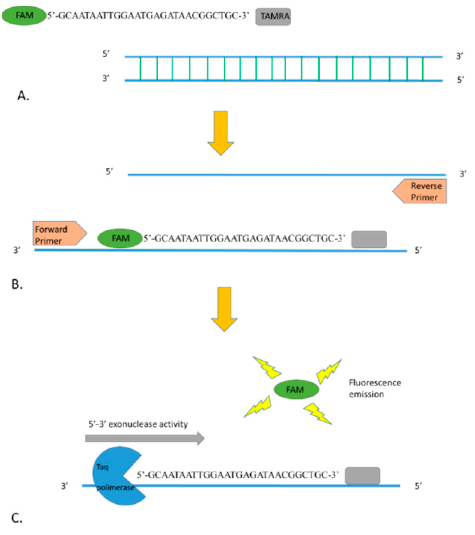
Figure 4. ( A ) Fluorescence of FAM fluorophore at the 5 ′ end of the probe is quenched by the TAMRA (quencher) present at the 3 ′ end. ( B ) During the annealing step of the RT-PCR, the probe is incorporated in the target sequence. ( C ) Exonuclease activity of the Taq polymerase during the amplification degrades the probe, and the fluorophore can release the fluorescence.